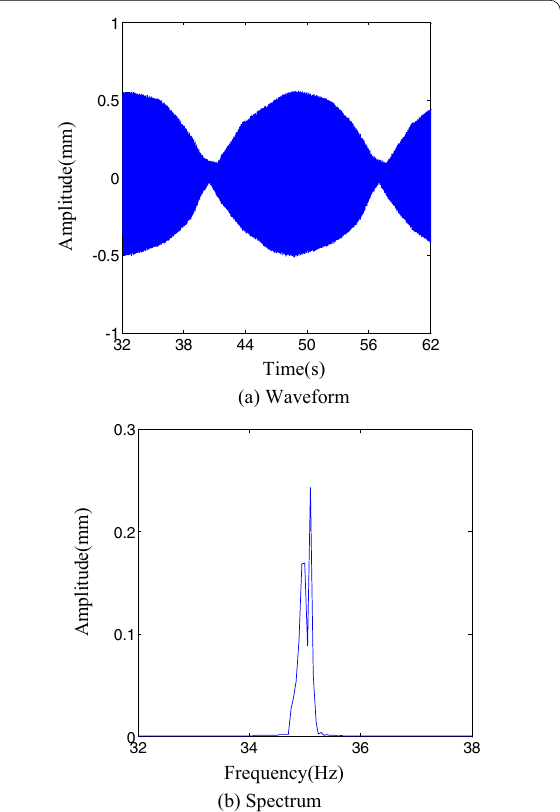
Figure 17 Waveform and spectrum in the x -direction when the speed of the disc and the speed of the shaft is